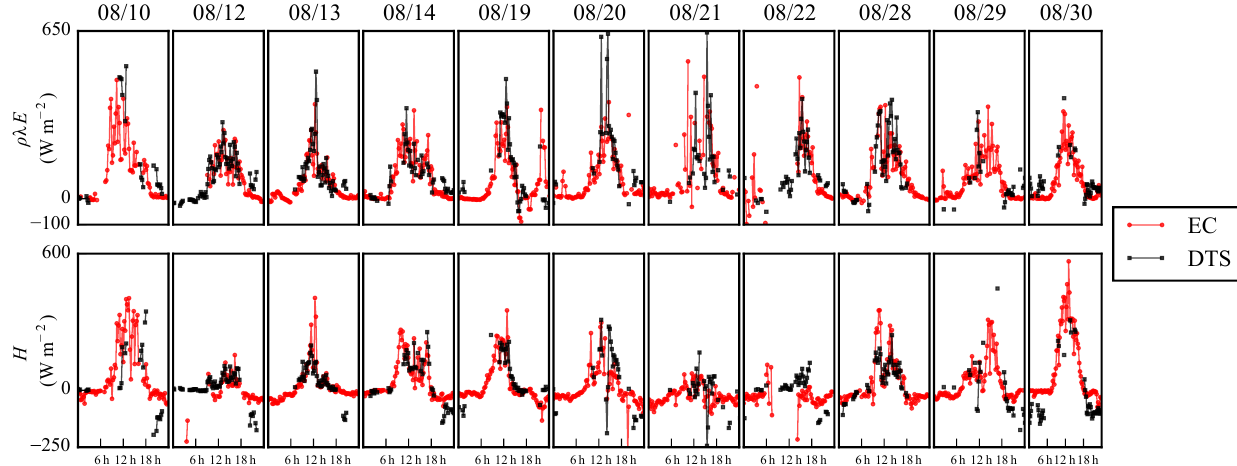
Figure 10. Plot comparing the BR-DTS and EC measured sensible ( H ) and latent ( ρλE ) heat fluxes over time (15min averages). Data from 10, 12–14, 19–22, and 28–30 August